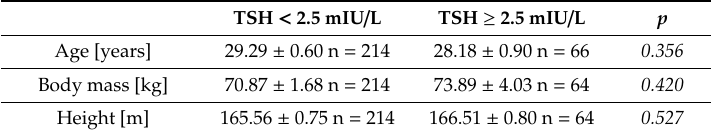
Table 1. Mean values ( ± SEM) of clinical / anthropometric / laboratory parameters in a subgroup with TSH < 2.5 mIU / L and in the subgroup with TSH ≥ 2.5 mIU / L, evaluated in the group of 280 inpatients with normal thyroid tests. Comparison between subgroups was performed by Student’s unpaired t -test. Statistical significance was determined at the level of p < 0.05. Statistically significant di ff erences are shaded. The level of statistical significance is given in italics. RBC: red blood cells, Hgb: hemoglobin, WBC: white blood cells, FT4: free thyroxine, FT3: free triiodothyronine, TPOAb: thyroid peroxidase antibodies, TgAb: thyroglobulinantibodies, TSHRAb: TSHreceptorantibodies, HDLC:HDLcholesterol, LDLC: LDL cholesterol, TGs: triglycerides, CRP: C-reactive protein, ESR: erythrocyte sedimentation rate, IRI: insulin resistance index.